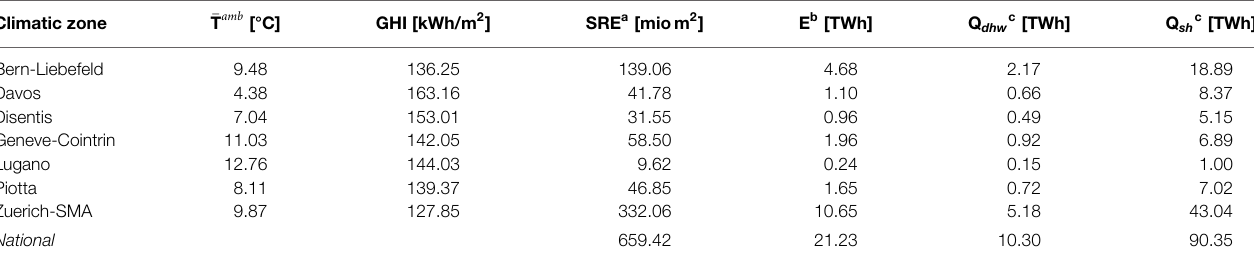
TABLE 1 | Annual demand and climatic